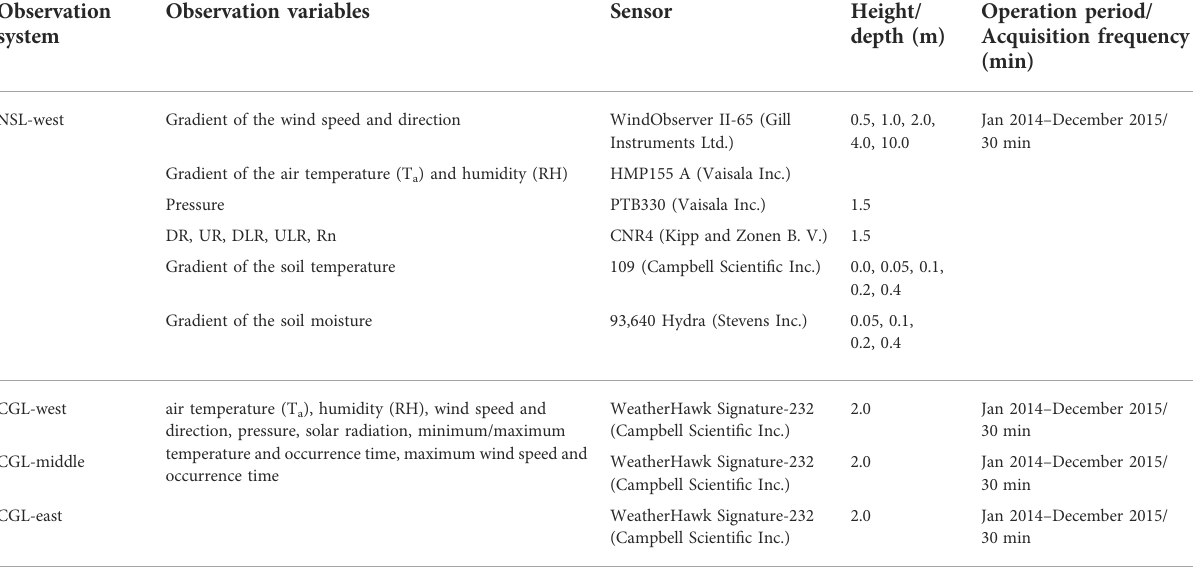
TABLE 1 Introduction to observation systems (NSL-West, CGL-West, CGL-Middle, CGL-East). Observation